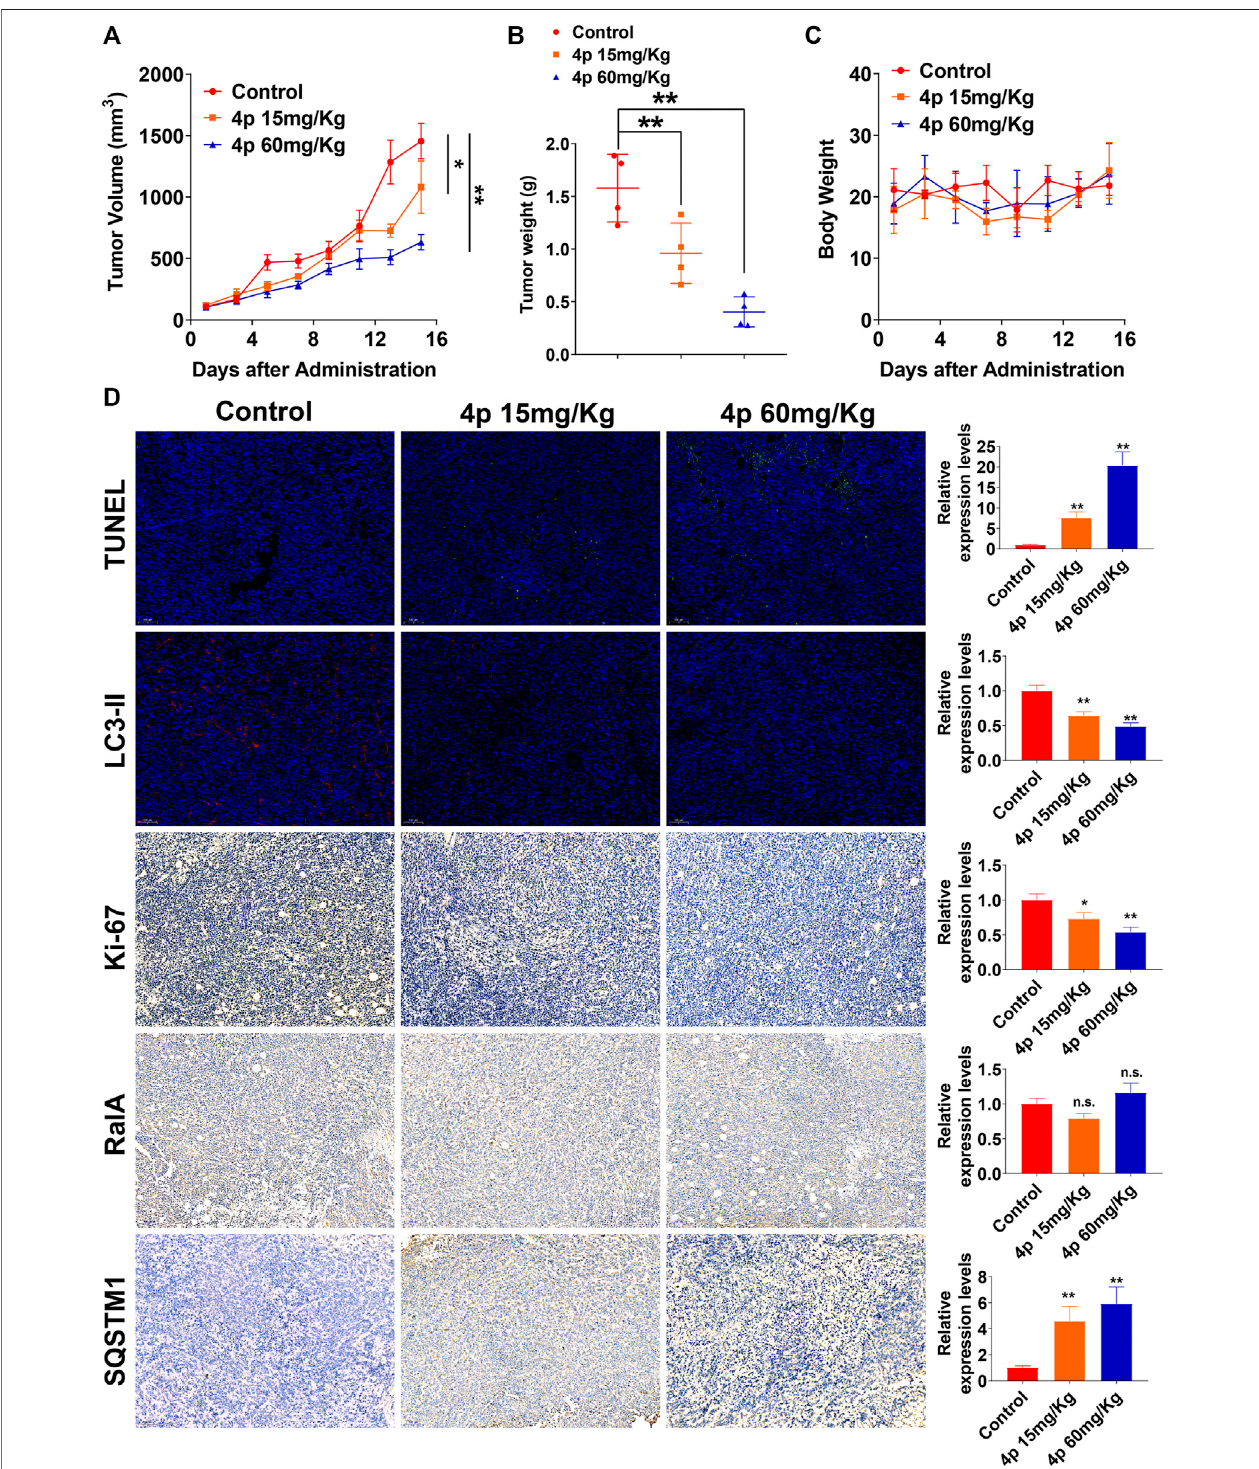
FIGURE 6 | Compound 4p inhibited tumor growth in a HepG2 xenograft model. (A) Tumor volume changes were determined every 2 days after drug administration; (B) Tumor weight in each mouse in (A, C) The body weight of mice in each group; (D) Immuno fl uorescence and IHC images and analysis of tissue sections stained by TUNEL, Ki-67, RalA, LC3-II, and SQSTM1 in each group, scale bar: 100 μ m.